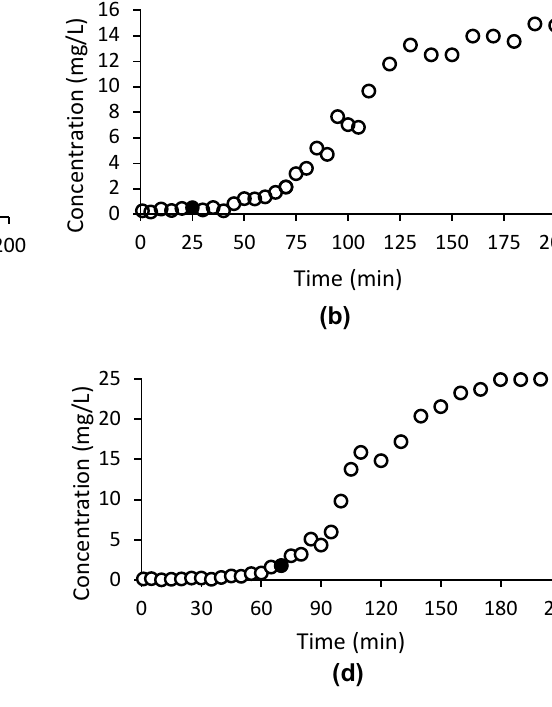
(filled circle) represents the breakpoint in each case. The data plot- ted represent the mean of three experimental runs for each operating condition